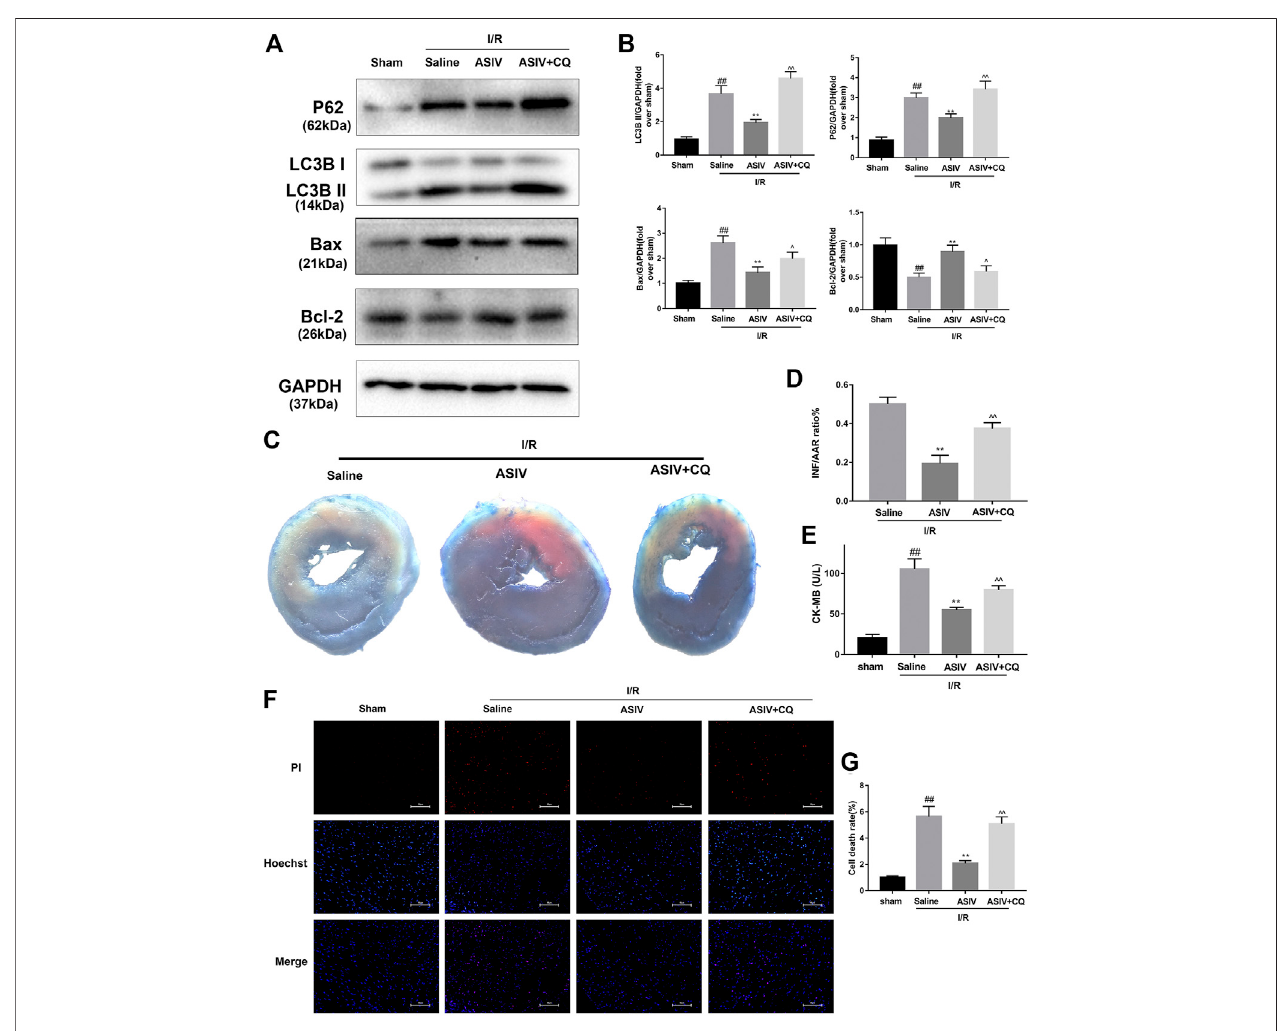
FIGURE 4 | ASIV attenuated I/R injury via attenuating I/R-induced autophagosome accumulation. Mice were pretreated with CQ (10 mg/kg; i.p.)1 h before ischemia and ASIV (20 mg/kg-1; i.p.) during reperfusion, then killed at 4 h after reperfusion for detection of (A, B) Western blot indicating expression of LC3B,P62, Bax andBcl-2proteins. (C,D) TTCstain, (E) SerumCK-MBlevels, (F,G) PIstain,scalebar:50 μ m n (cid:2) 6.Valuesareexpressedasthemeans ± SD.# p < 0.05comparedwith the sham group, * p < 0.05 compared with the I/R group, ^ p < 0.05 compared with the ASIV group (each test was repeated three